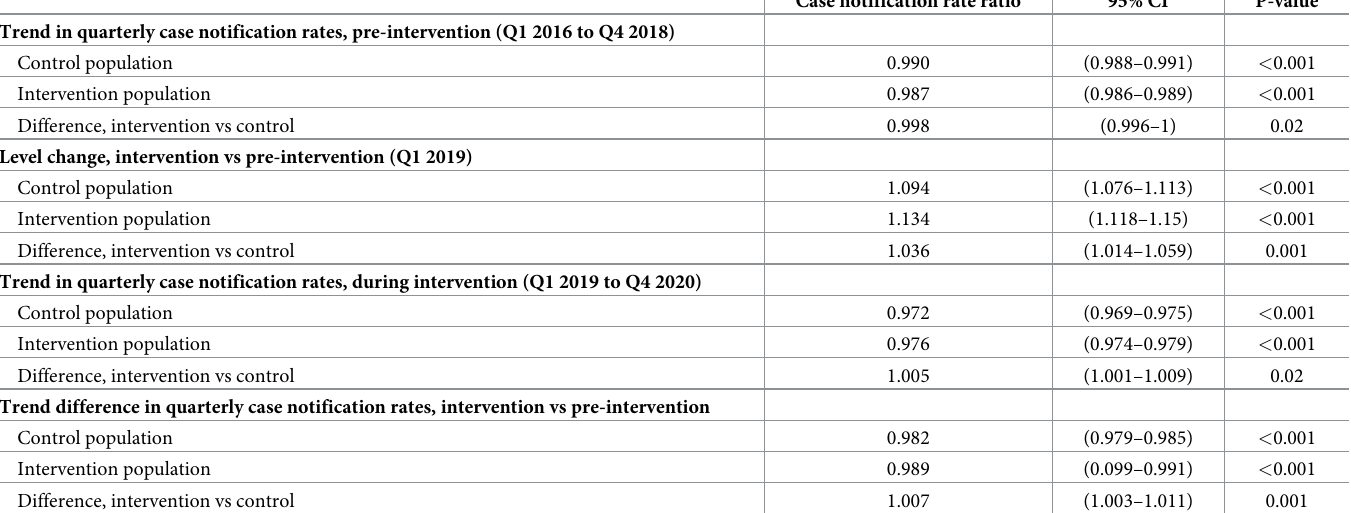
Table 3. Modelled trend and level changes in quarterly case notification rates before and during the intervention period, in control and intervention populations for all forms TB, from Q1 2016 to Q4 2020.